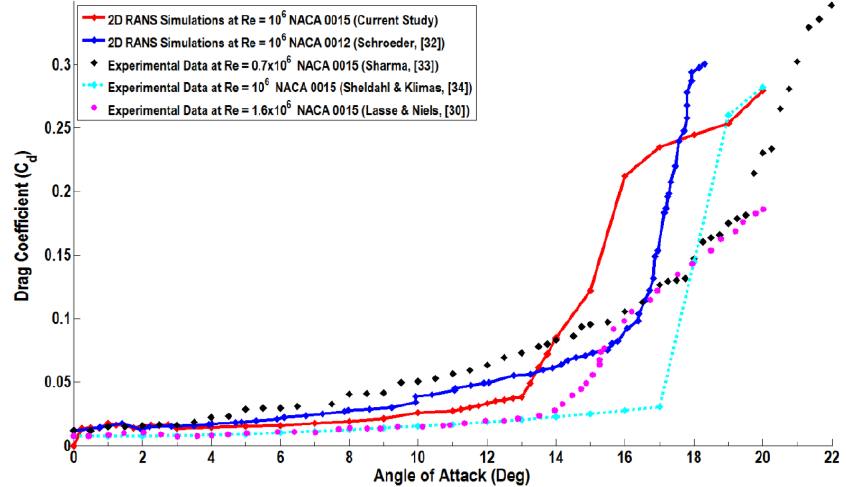
Figure 12. Comparison of drag coefficient of airfoil at 0° flap deflection versus angle of attack at chord Reynolds number Re = 10 6 with the experimental data and earlier numerical results.